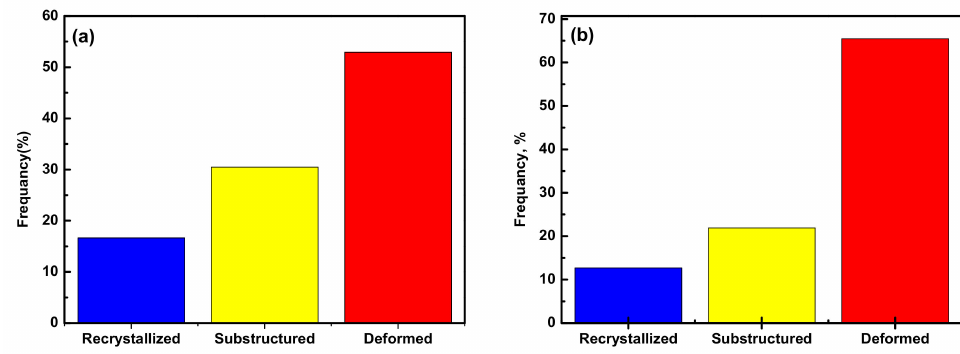
Figure 13. Recrystallized fraction chart for Ti6Al4V-5Cu alloy after deformation at 840 ◦ C and different strain rates of ( a ) 0.01 s − 1 and ( b ) 0.001 s − 1 .